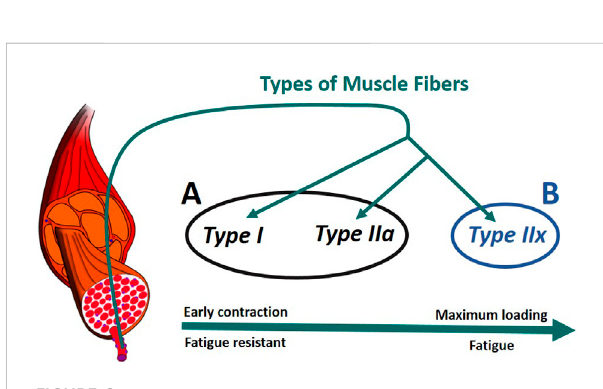
FIGURE 6 Muscle recruitment hierarchy as function of the fi ber (Radák, 2018). (A) composed of type I and type IIa fi bers. (B) formed of type IIx fi bers. The muscle fascicles and cells is licensed under Sheldahl, CC BY-SA 4.0, (via Wikimedia